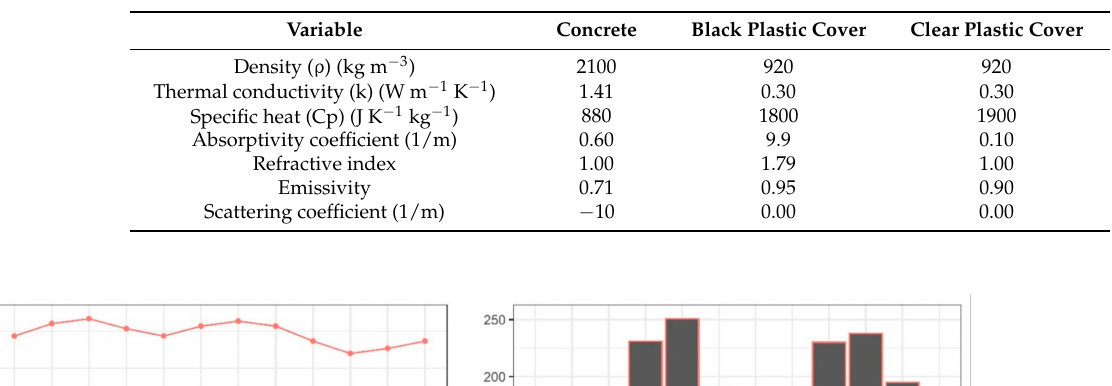
Table 3. Thermo-physical and optical properties of materials in the computational domain. Taken from Osorio H et al. [38].